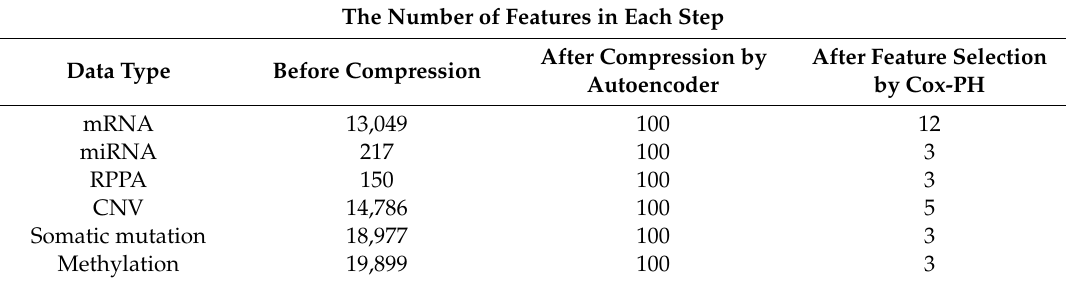
Table 2. The summary of data